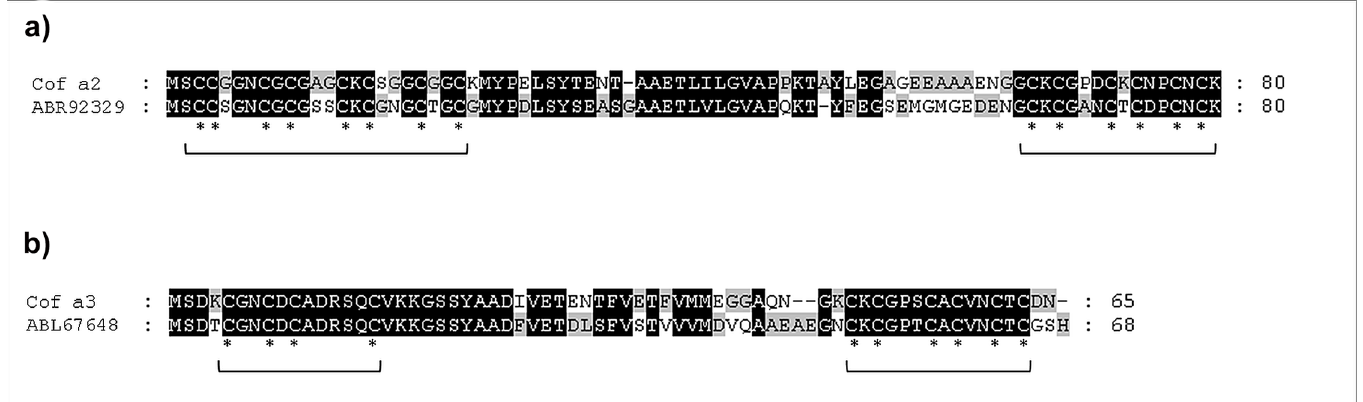
Fig 3. Alignement of the amino acid sequences. a: Cof a 2 and a Salvia miltiorrhiza metallothionein type II (ABR92329). b: Cof a 3 and a Citrus hybrid metallothionein type III (ABL67648) identified by BLAST search. Homologous regions with previously described metallothioneins are highlighted in black. The typical highly conserved domains of the cystein ( * ) arrangements of plant metallothioneins II and III are indicated by a square bracket.